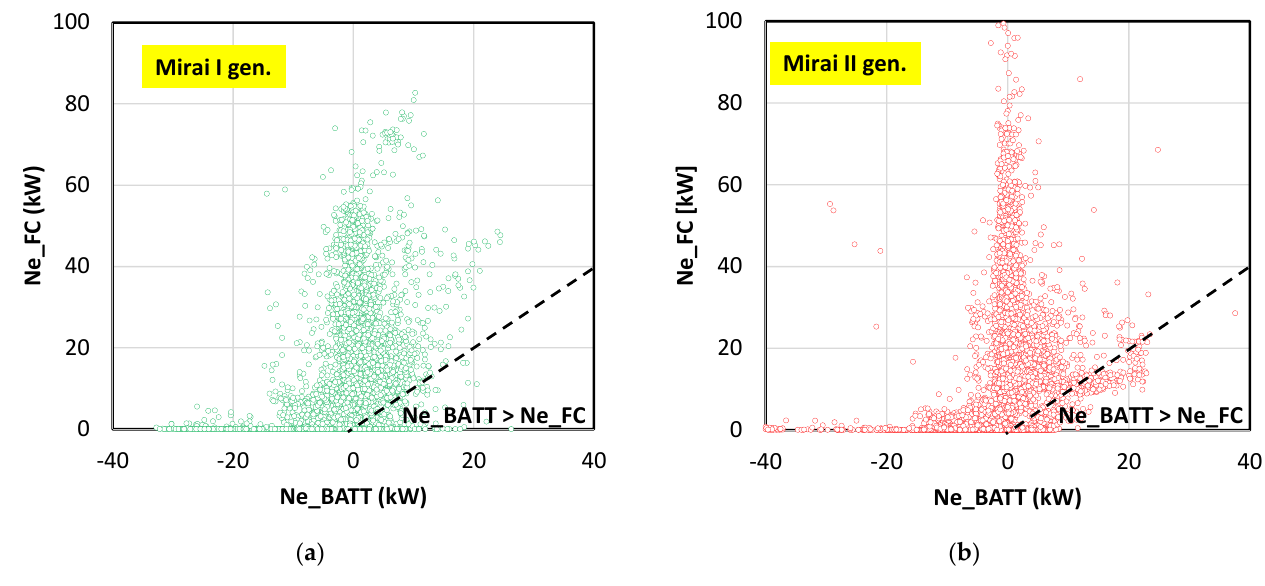
Figure 13. Share of use between the fuel cell and the battery: ( a ) first-generation drive; ( b ) second-generation drive.